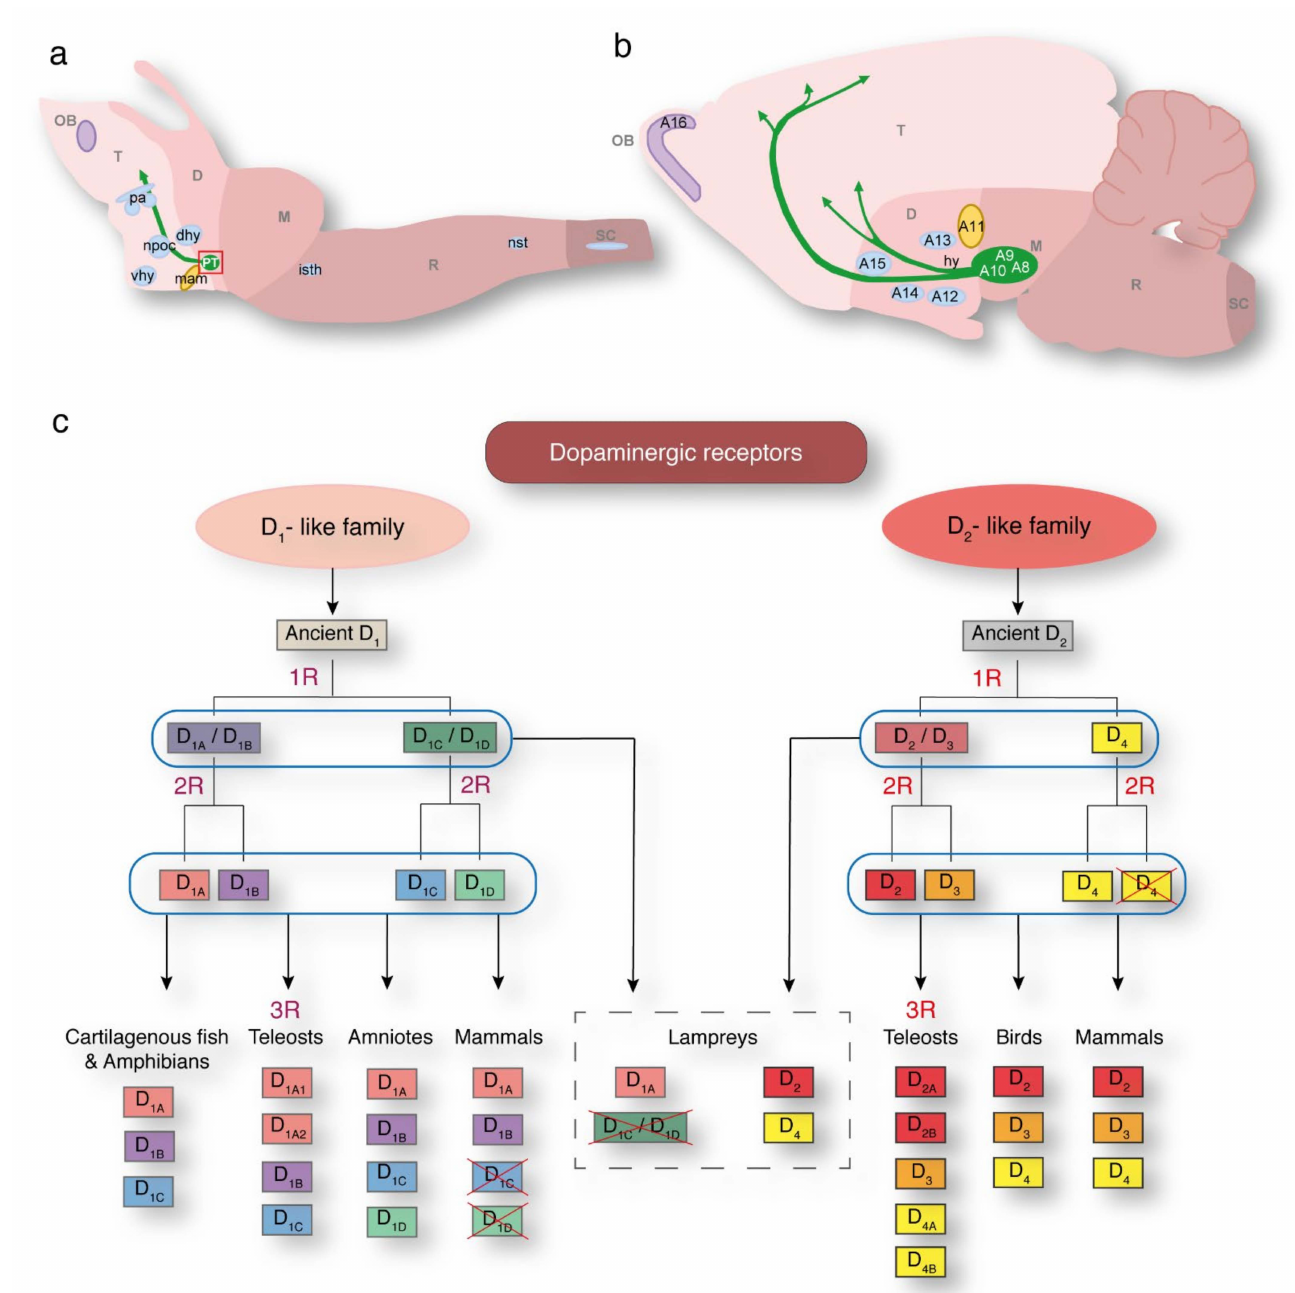
Figure 1. Distribution of dopaminergic neuronal cell groups in the brain of a basal vertebrate (lamprey, a ) and a mammal (rat, b ). In the lamprey, as in other vertebrates, dopaminergic cells are distributed in discrete populations from the olfactory bulb to the hypothalamus and rhombencephalon, as illustrated schematically in a sagittal view ( a ). The most rostral dopaminergic population in lamprey (purple) is located in the olfactory bulbs and would therefore correspond to the mammalian A16 group. In the preoptic area, there are CSF-contacting cells that resemble the suprachiasmatic nucleus population of other vertebrates [7]. There are also a few populations in the hypothalamus. The population located in the PT (green, and highlighted by a red square) is the homologue of the mammalian substantia nigra pars compacta /ventral tegmental area (SNc/VTA). Green arrows indicate the nigrostriatal projection in the lamprey brain, and the nigrostriatal, mesolimbic, and mesocortical pathways in the rat brain. The population in the mammillary area in lamprey (yellow) has been proposed to be the homologue of the mammalian A11 group due to its projections to the spinal cord [12]. Blue areas indicate dopaminergic populations whose homology has not yet been determined. Two populations in the